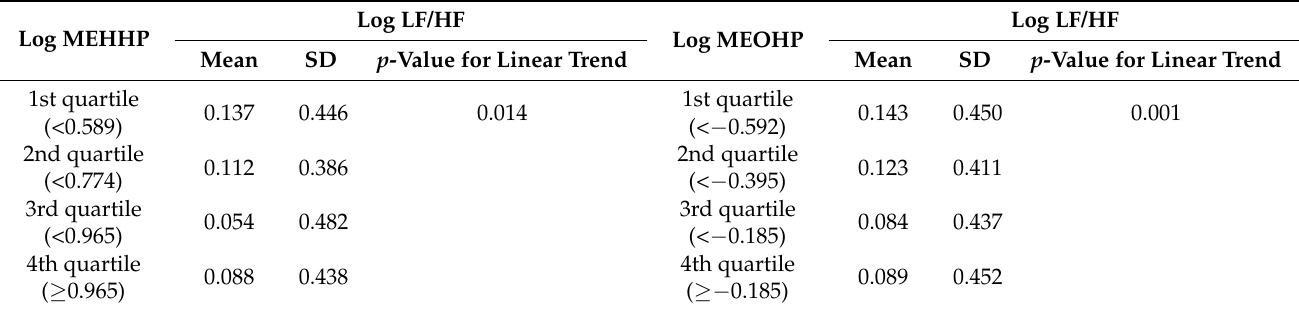
Table 6. One-way analysis of variance for urinary phthalate metabolites and the autonomic balance, LF/HF ratio. Log